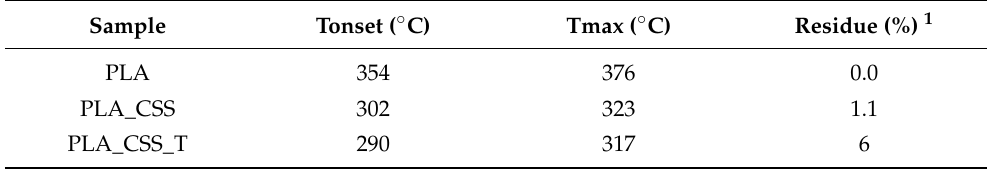
Table 3. Thermogravimetric analysis results of the investigated materials. Sample